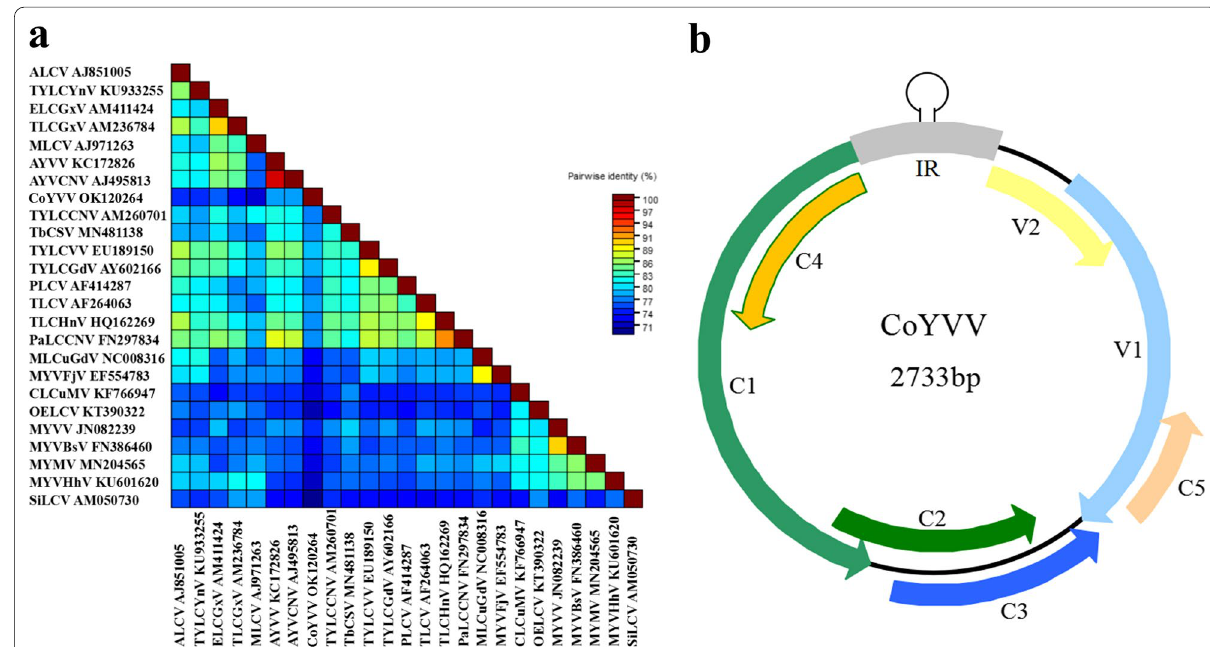
Fig. 1 Comparison of CoYVV genome sequence with that of other begomoviruses, and analysis of CoYVV genome structure. a Color-coded pairwise identity matrix generated from 25 complete begomovirus DNA-A sequences (Additional file 1: Table S2). The matrix was generated using the Sequence Demarcation Tool (SDT v.1.2). The colored cell representing a percentage identity score for two sequences. b Schematic representation of the genome organization of CoYVV. Different colors represent different open reading frames